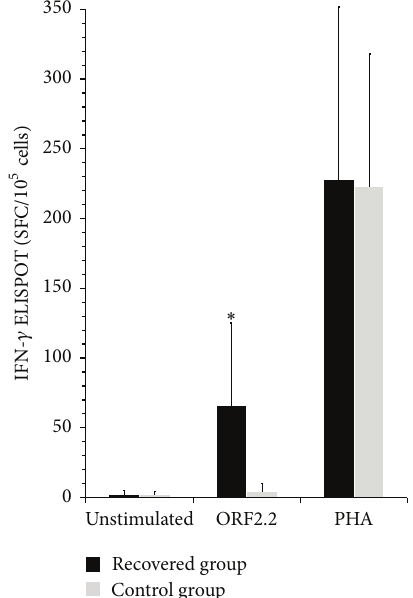
Figure 1: Cell proliferative responses in HEV-recovered individuals and control group. Proliferative responses to the truncated ORF2 protein are significantly higher in HEV-recovered group compared to the control group, while both groups showed good nonspecific stimulation with PHA. The results are shown as proliferation index (mean ± SD PI).